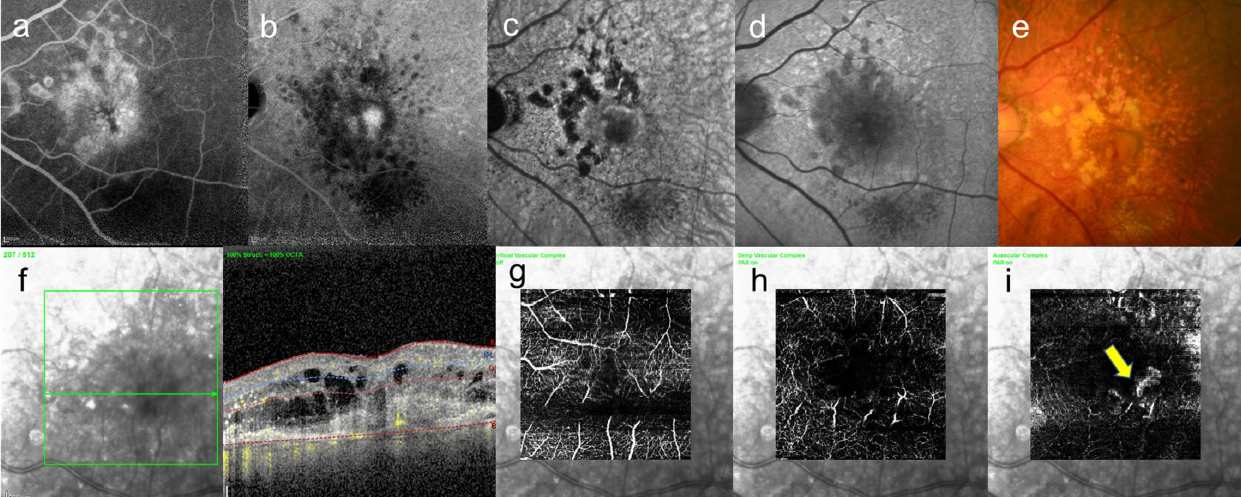
Figure 5. Same case as Figure 4. These images are left eye with 20/250. This eye is contralateral eye of above figures. ( a ) leakage became enlarged gradually on FA image acquired at 15 min, and ( b ) abnormal hypofluorescence and leakage became enlarged on ICGA image acquired at 25 min, and leakage can be seen around the fovea, ( c ) near-infrared autofluorescence image, abnormal hypofluorescence can be seen broadly which corresponds to the hypofluorescent area of ICGA images, ( d ) short-wavelength fundus autofluorescence image, abnormal hyperfluorescence and hypofluorescence can be seen broadly, ( e ) color fundus photograph, drusen and geographic atrophy can be seen broadly, ( f ) infrared + OCT angiography (horizontal section) through the fovea, ( g ) superficial vascular segment OCT angiography, ( h ) deep vascular segment OCT angiography, ( i ) avascular segment OCT angiography, where there is macular neovascularization (arrow).